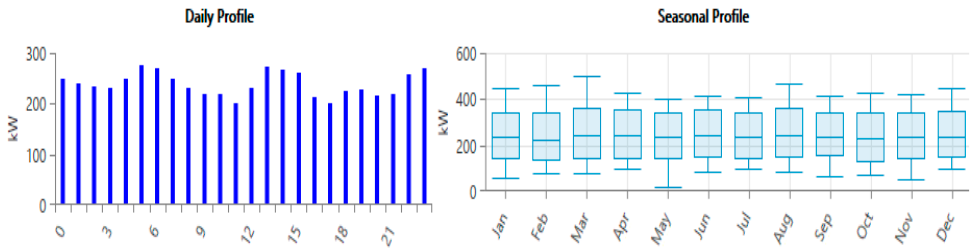
Figure 13. Daily and seasonal profiles for solar Energy at KHMG.